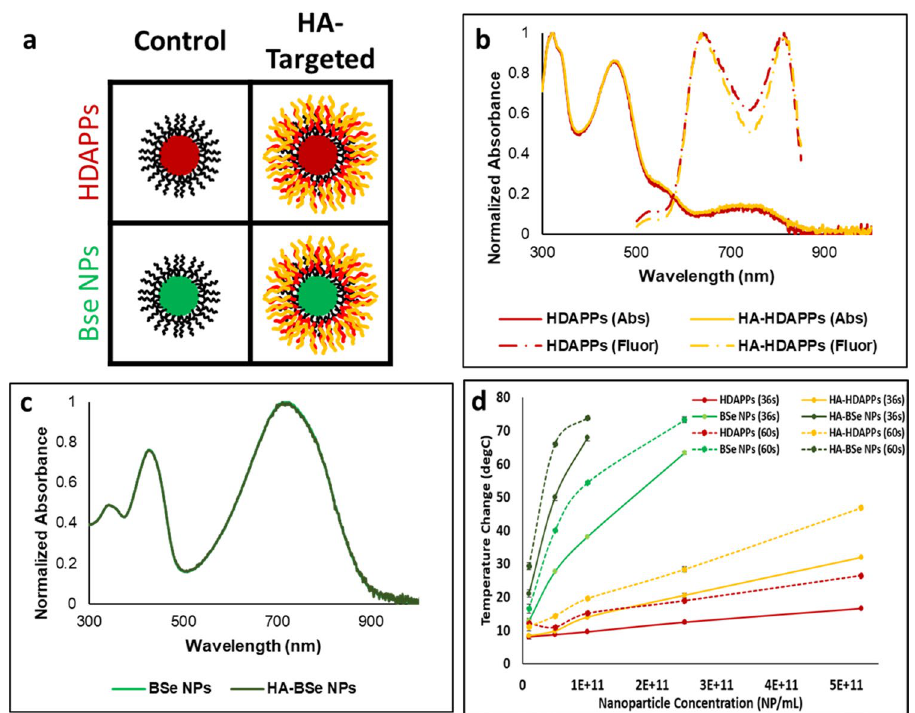
Figure 2. Targeted semiconducting polymer nanoparticle physical characterization. ( a ) Panel of fluorescent HDAPPs and ablative BSe NPs variants used within experimentation, either uncoated, or with HA. ( b ) HDAPPs and HA-HDAPPs UV/Vis absorbance and fluorescence spectra indicate no loss in characteristic activity due to coating with HA. ( c ) BSe NPs and HA-BSe NPs UV/Vis absorbance spectra indicate no loss in characteristic activity due to coating with HA. ( d ) Heating potentials of HDAPPs, BSe NPs, and their HA-coated variants were measured by exposing NPs in a 100 µL volume to 800 nm laser at specified laser durations. This illustrates the capacity of each nanoparticle to reach ablative potential at relatively low concentrations in bulk solution phase. (Error bars reported as